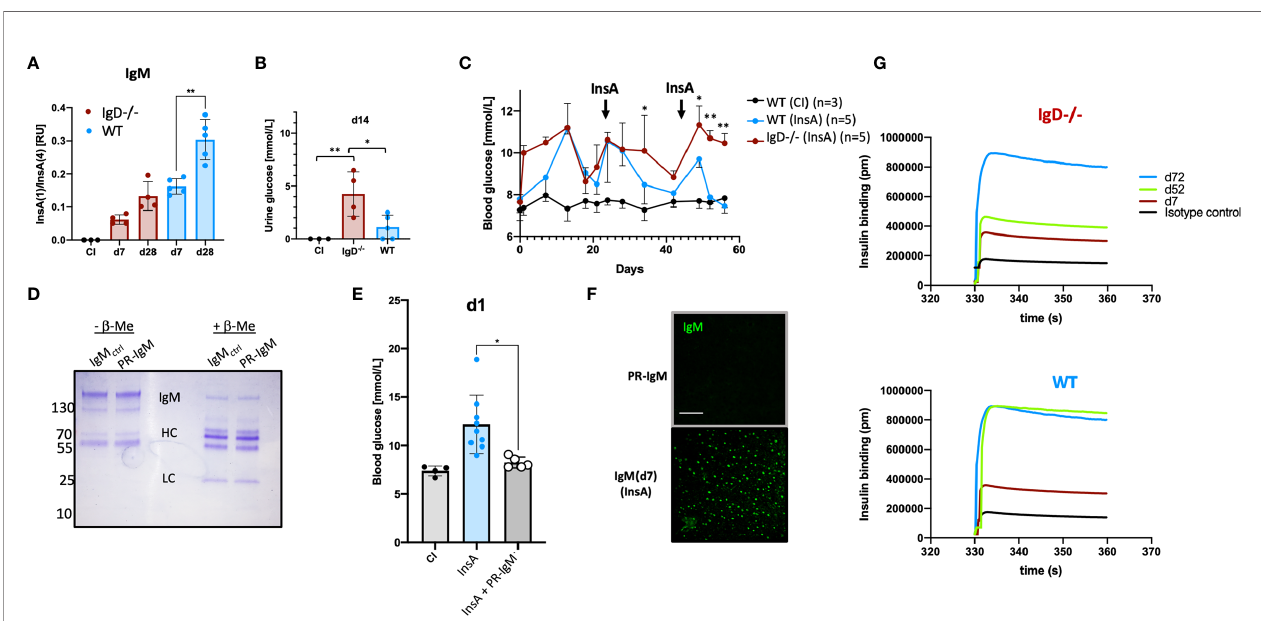
FIGURE 4 | The IgD-class BCR is required for af fi nity maturation of insulin-IgM to be protective and prevent autoimmune pathology. (A) Af fi nity of IgM to InsA peptides of InsA (InsA-KLH + CpG ODN1826) immunized IgD-de fi cient (n=4), WT (n=5) and CI (n=3) mice measured by peptide-ratio ELISA (22).Plates were coated with Streptavidin bearing one [InsA(1)] or four [InsA(4)] biotin binding sites. Mean, ± SD, statistical signi fi cance was calculated by using repeated measure ANOVA- test. (B) Urine glucose values (mmol/L) measured by commercial urine stripes (Roche) of IgD-de fi cient (n=4) and WT (n=5) mice immunized with InsA-KLH or CI (n=3). Mean, ± SD, statistical signi fi cance was calculated by using Kruskal-Wallis-test. (C) Blood glucose values (mmol/L) of IgD-de fi cient (n=4) and WT (n=5) mice immunized with InsA. Injections were done on day 0 (InsA-KLH + CpG ODN1826), day 21 (InsA-KLH), day 42 (InsA-KLH). Mean, ± SD, statistical signi fi cance was calculated by using repeated measure ANOVA-test comparing red and blue graphs. (D) Coomassie-stained SDS-PAGE showing reduced (+ b -ME) and non-reduced (- b -ME) IgM of cInsA and control immunized mice. Total serum IgM was isolated via HiTrap IgM columns (InsA d85 refers to PR-IgM). IgM monomer: 150 kD, IgM HC: 70 kD, IgM LC: 25 kD. (E) Blood glucose values (mmol/L) of IgD-de fi cient immunized with InsA-KLH (n=9), WT control immunized mice (n=4) and IgD-de fi cient mice immunized with InsA-KLH and injected with PR-IgM i.v. (n=5). Mean, ± SD, statistical signi fi cance was calculated by using Kruskal-Wallis-test. (F) Serum immunoglobulins reactive to self-molecules (DNA/RNA) of IgM (PR-IgM and day 7 primary IgM) isolated from InsA-KLH immunized mice tested via HEp2 slides. Fluorescence microscopy images are representative for three independent experiments. Scale bar: 10 µm. (G) Interferometric assay to determine the af fi nity of IgM to insulin. Insulin-speci fi c isolated IgM of IgD-de fi cient (top panel) or WT (bottom panel) mice immunized with InsA. Af fi nity of IgM of different days is shown in pm. Graphs are representative of three independent experiments *P < 0.05, **P <